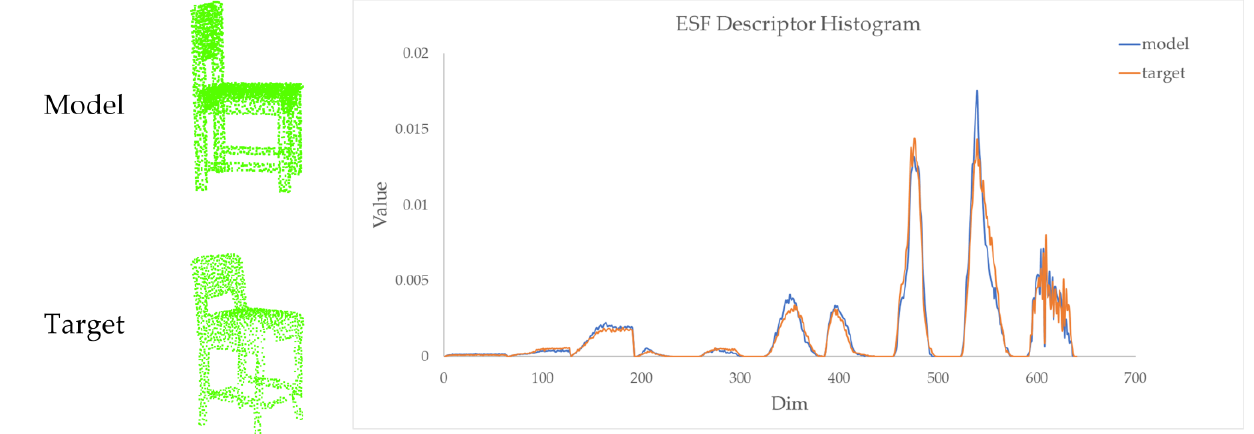
Figure 7. ESF descriptor histograms. The ESF descriptor histograms of target (orange) and model